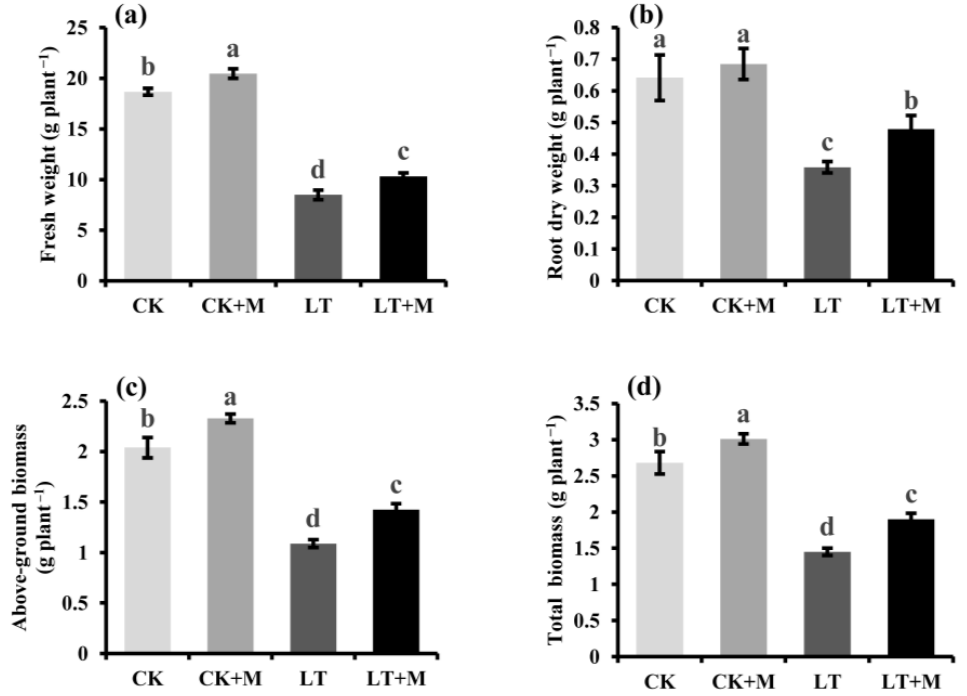
Figure 1. Effects of wood vinegar on the biomass of rapeseed seedlings fresh weight ( a ), root dry weight ( b ), above-ground biomass ( c ), and total biomass ( d ) under low-temperature stress. According to the LSD test, the lowercase letters in the figure indicate significant differences ( p < 0.05). Error bars are ± SE (n = 5). CK, normal temperature; CK + M, normal temperature + wood vinegar; LT, low temperature; LT + M, low temperature + wood vinegar.